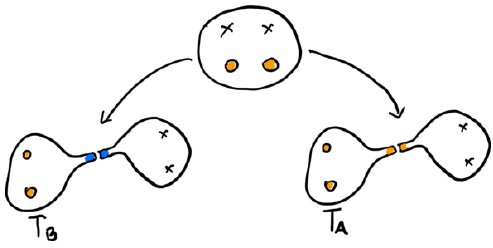
Figure 7 . Two dualities for the orbifold theory. The orbifold theory corresponds to four punctured sphere with two maximal puntures of same color and two minimal punctures. Taking the limit of the maximal punctures sitting on same pair of pants we develop a long tube and decompose the surface into trinions. There are many ways to do so distributing compensating discrete charges between the two trinions. The two trinion theories we discussed are obtained by decomposing the tube in two di(cid:11)erent ways. First one corresponding to the procedure detailed in the text using interacting trinion, and second using free